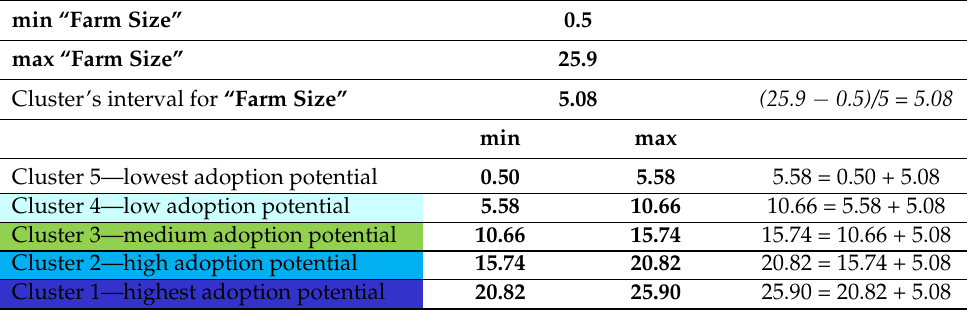
Table 7. Calculations for the “cluster interval” for variable “Farm Size”.